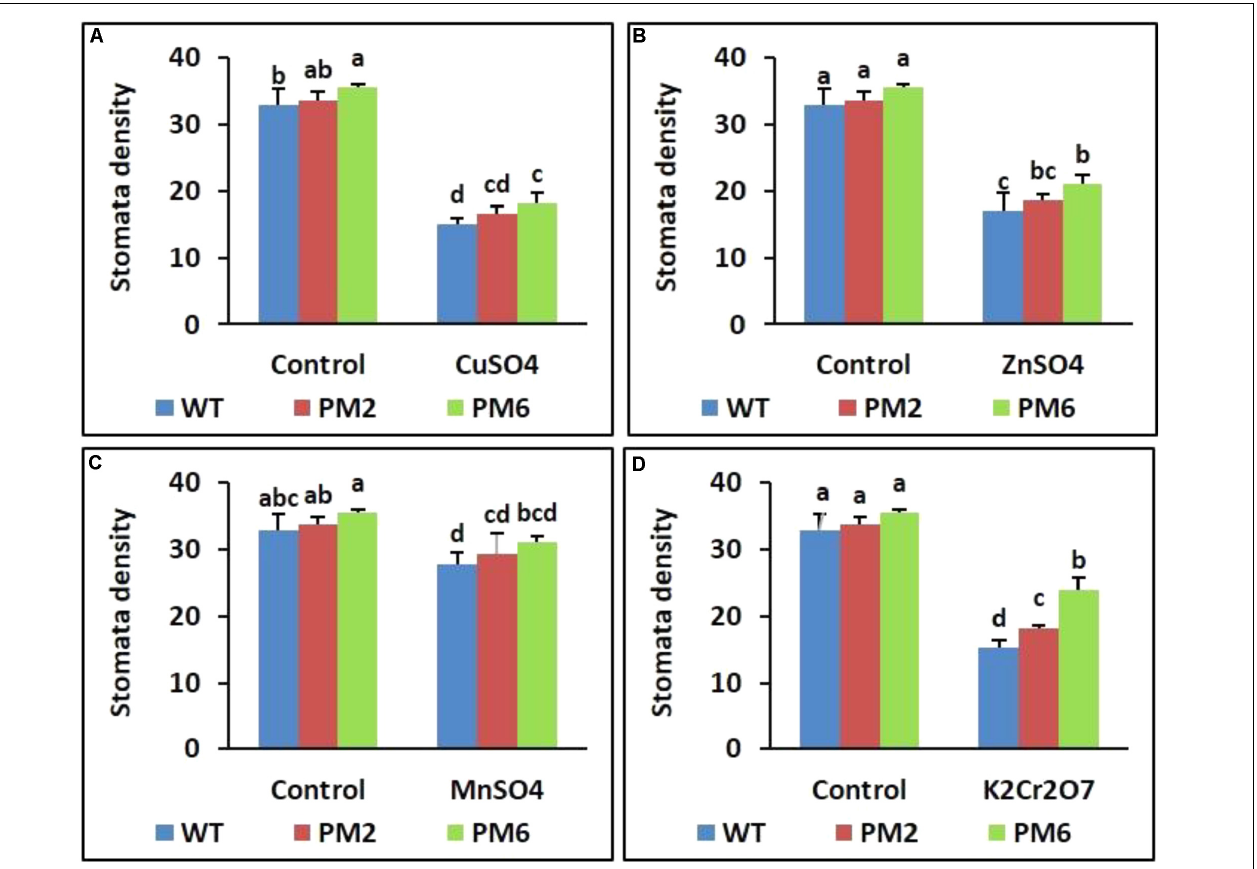
FIGURE 7 | Comparison of stomatal density in the T 2 -PM6, T 2 -PM2, and WT plants after exposure to the indicated heavy metals ( A , CuSO 4 ; B , ZnSO 4 ; C , MnSO 4 ; D , K 2 Cr 2 O 7 ). Data were taken on the thirtieth day after starting the experiments. Error bars show the